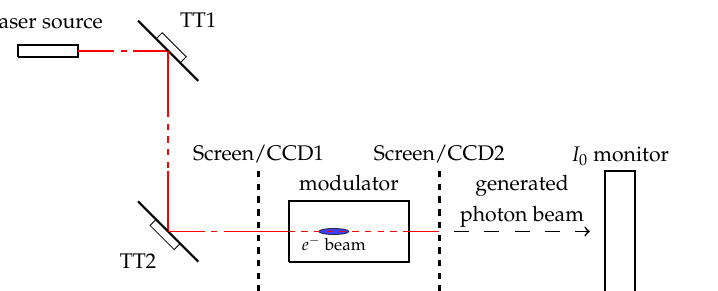
Figure 1. Simple scheme of the FERMI FEL seed laser alignment set up. TT1 and TT2 are the tip–tilt mirrors, Screen/CCD1 and Screen/CCD2 are two removable Yttrium Aluminum Garnet (YAG) screens with Charge Coupled Devices (CCDs) and I 0 monitor is the employed intensity